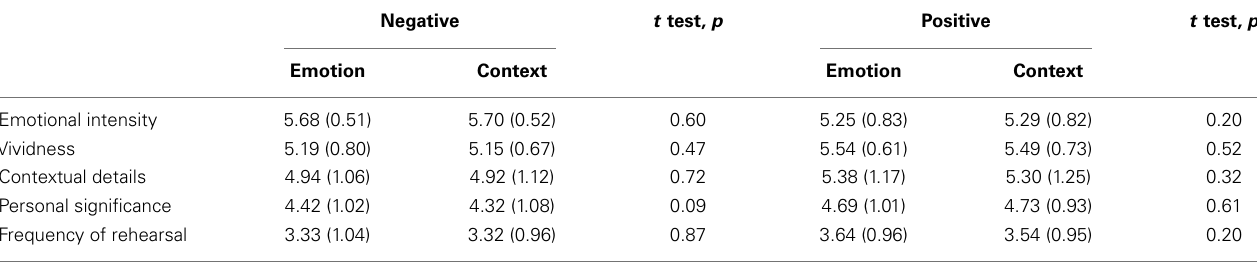
Table 1 | Phenomenological properties of the selected autobiographical